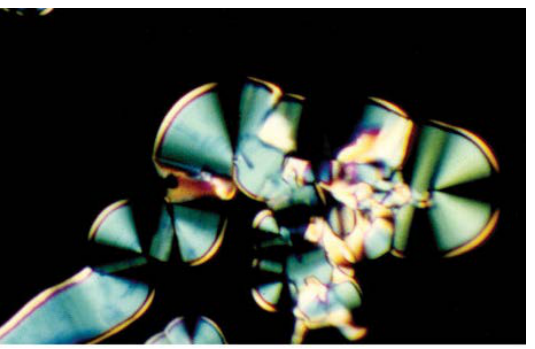
Figure 13. A ribbon of developable domains of the columnar phase of Intal, formed when the isotropic solution is cooled. Note the pattern of striations following the alignment of the director field. Hartshorne comments